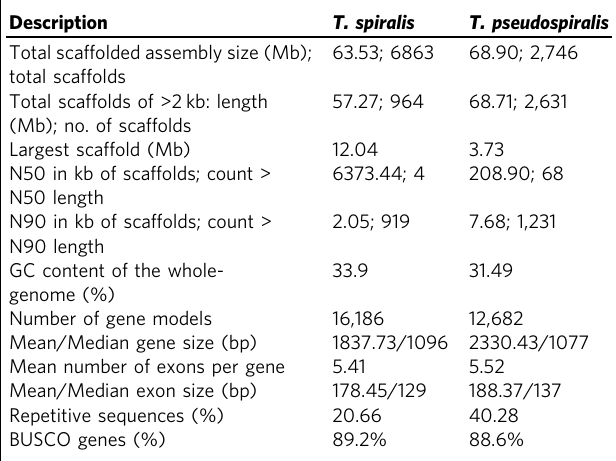
Table 1 Comparison of genome assembly and annotation between T. spiralis and T. pseudospiralis